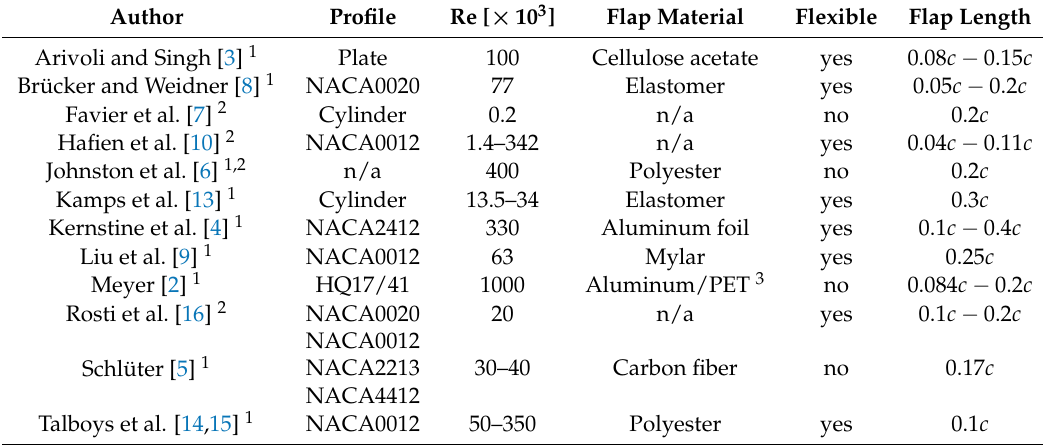
Table 1. Summary of the literature review with investigated profiles, Reynolds number Re of the flow, flap material, flexibility of the flap, and length with respect to the chord length of the profile c ; 1 Experimental study; 2 Numerical study; 3 Polyethylene